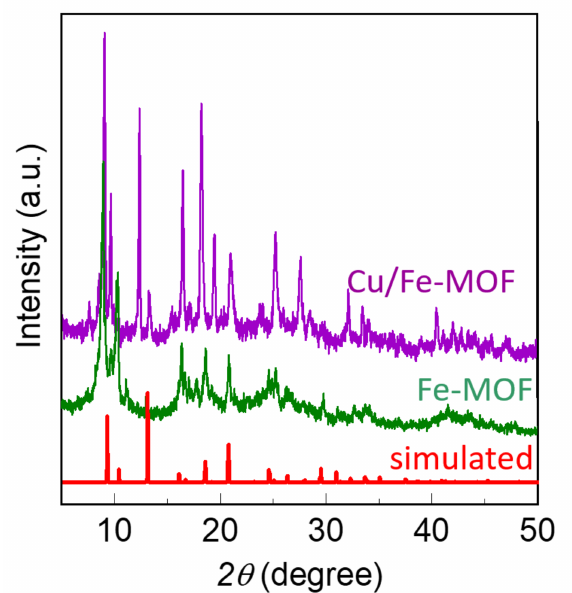
Figure 2. XRD patterns of the bulk powder MOFs and the corresponding simulated XRD patterns of the reference NH 2 -MIL-88